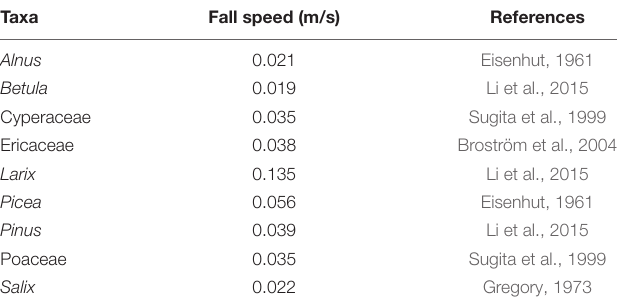
TABLE 2 | Fall speed of major taxa used to estimate relative pollen productivity (RPP) in this study. Taxa Fall speed